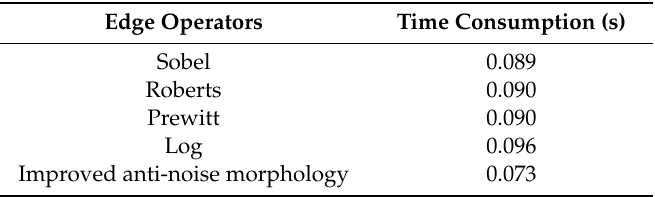
Table 3. Time consumption contrast of di ff erent edge operators.